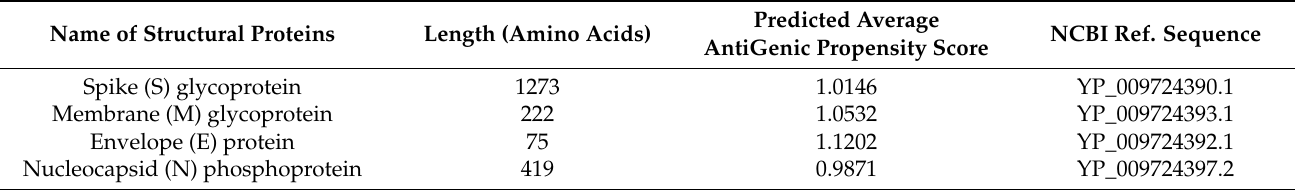
Table 2. Predicted average antigenic propensity of SARS-CoV-2 structural proteins (S, M, E, and N). The sequences of structural proteins were retrieved individually as FASTA format from NCBI database that is curated and designated for SARS-CoV-2 (SARS-CoV-2 Resources—NCBI (nih.gov). The sequences were uploaded individually to antigenic propensity prediction tool (http://imed.med.ucm.es/Tools/antigenic.pl, accessed on 17 October 2021) for calculation of their respective average antigenicity score. The score is considered as crucial information while designing and developing myriad of